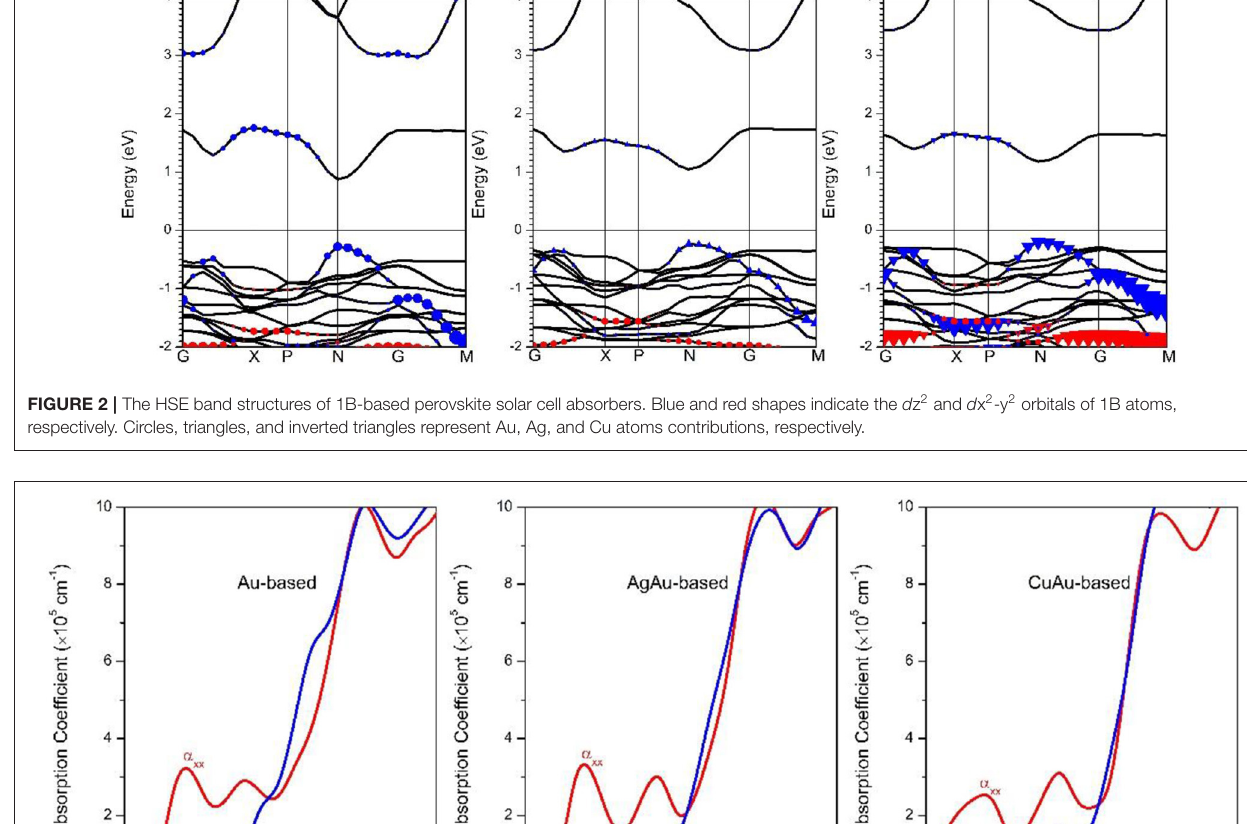
hole after photoexcitation; at the same time, the G